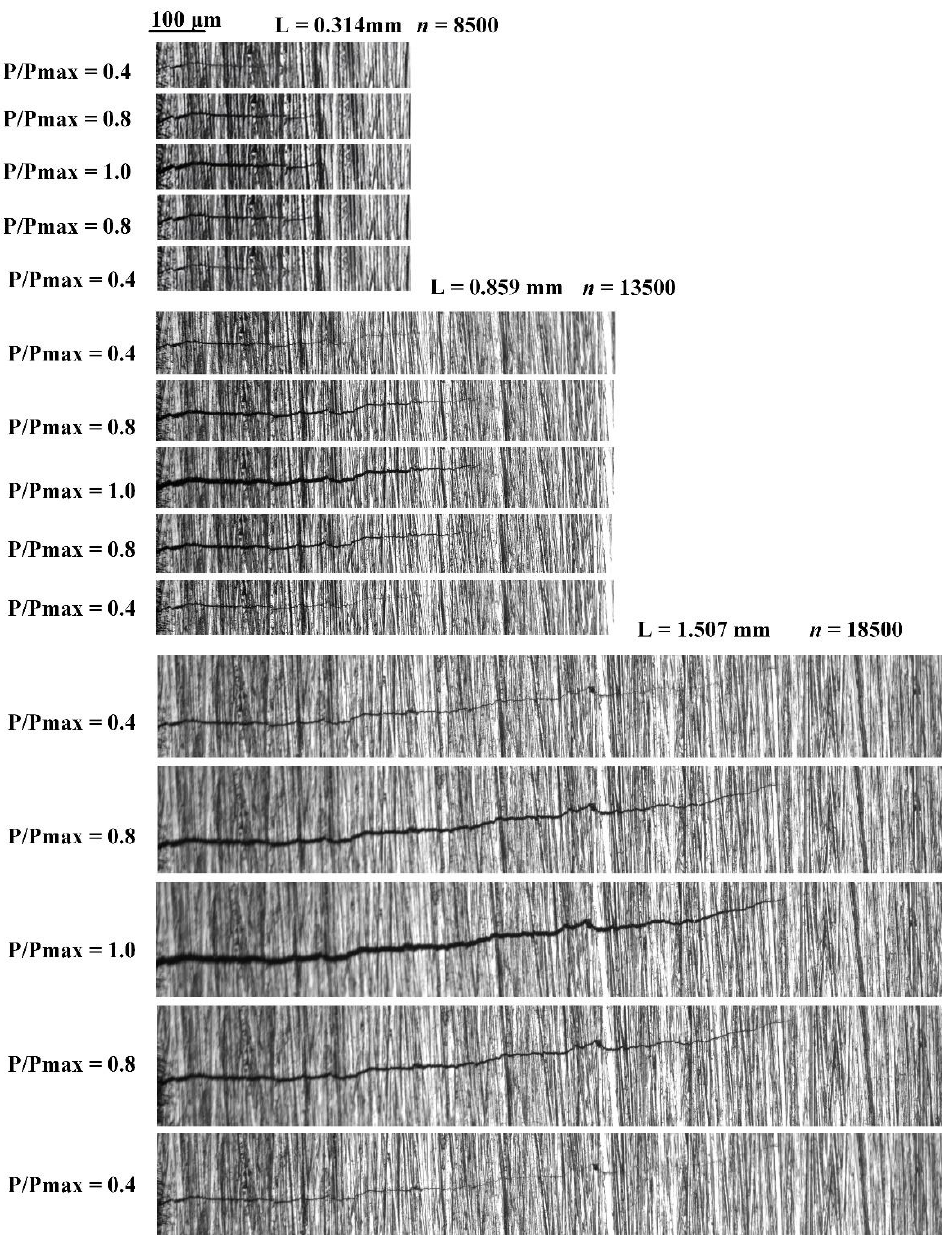
Figure 12. SFC morphology evolution during crack closure with stress ratio of 0.4.